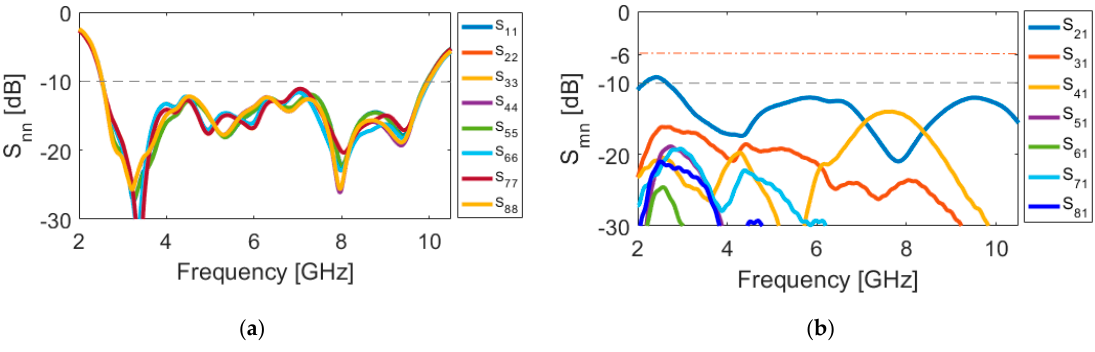
Figure 17. ( a ) S nn and ( b ) S mn characteristics of the simulated MIMO design.